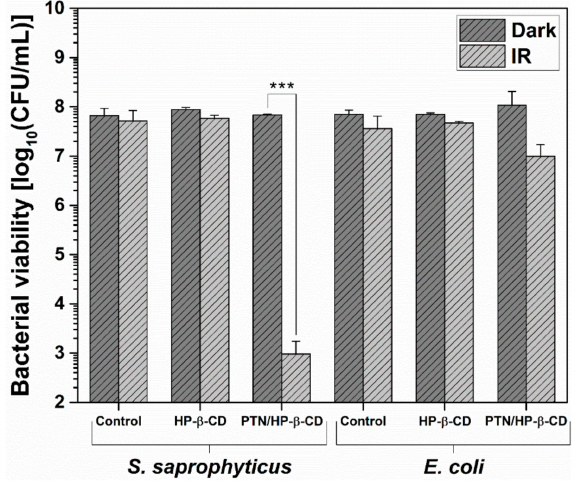
Figure 10. Bacterial viability of Staphylococcus saprophyticus subsp. bovis ( S. saprophyticus ) and Escherichia coli DH5 alpha ( E. coli ) treated with PTN/HP- β -CD complexes (100 µ M PTN) or only with HP- β -CD for 30 min at 37 ◦ C and then irradiated (IR) with a blue LED ( λ irr = 457 nm, 39.6 J/cm 2 ) or kept in the dark. Control represents bacterial suspension treated with filter-sterilized phosphate- buffered saline (PBS) (pH 7.4). The results are expressed as means ± SDs ( n = 3). Statistical differences are denoted as “***” p <